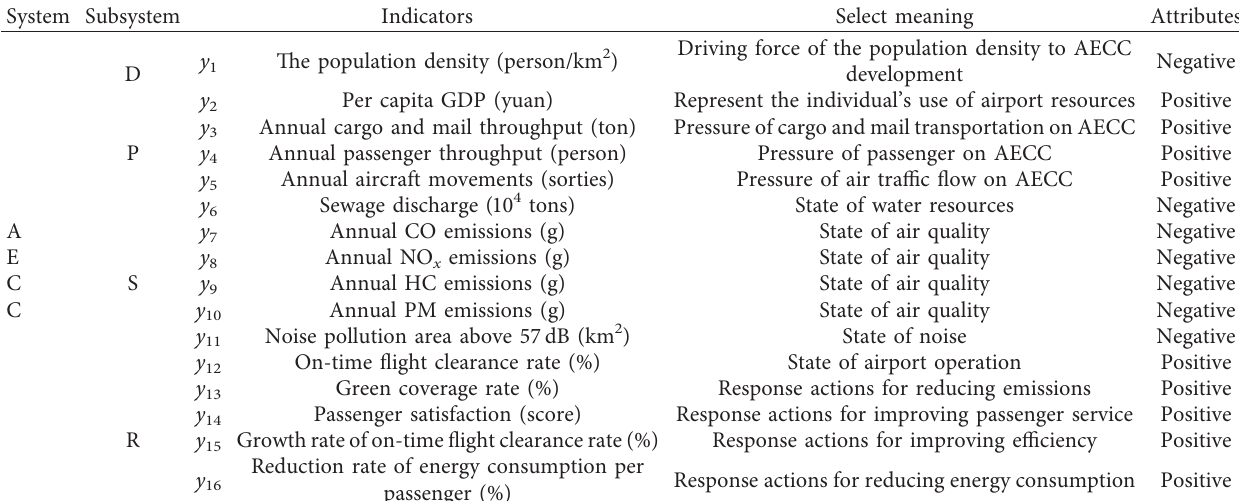
Table 1: The indicator system of AECC.